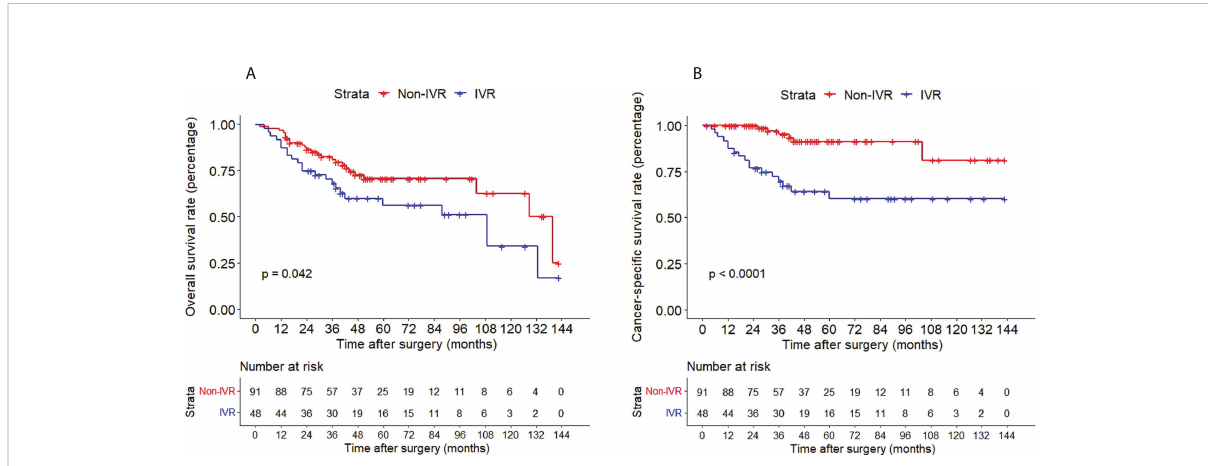
FIGURE 2 Kaplan – Meier curves for OS (A) , CSS (B) of patients with UTUC according to IVR. OS, overall survival; CSS, cancer-speci fi c survival; UTUC, upper tract urothelial carcinoma; IVR, intravesical recurrence.